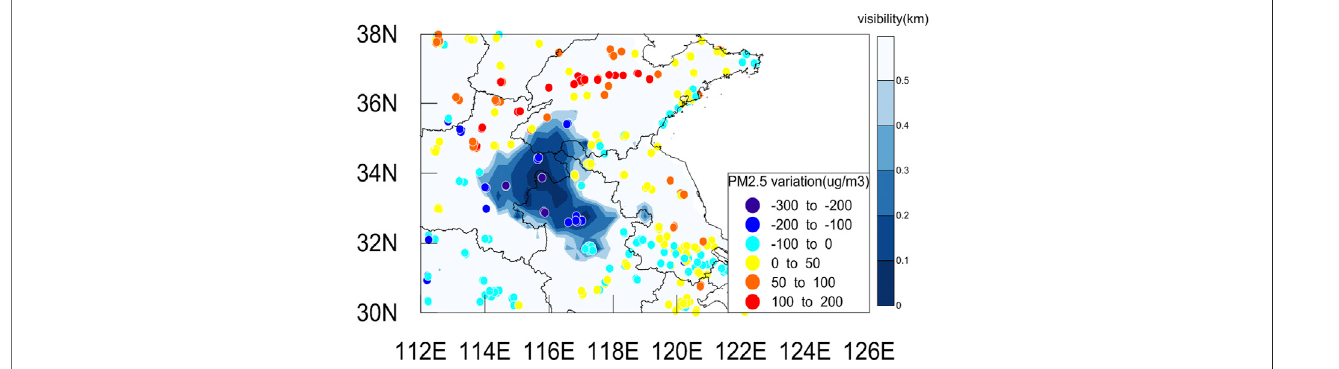
FIGURE 10 | Surface visibility distributions at 07:00 January 17 (colored areas) and PM 2.5 concentration difference from 20:00 January 16 to 07:00 January 17 (colored spots) in